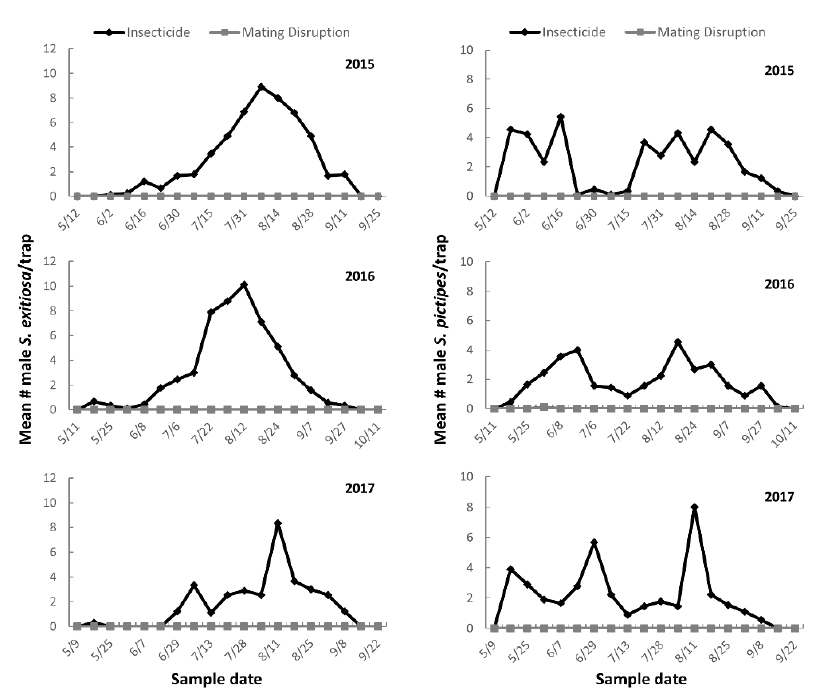
Figure 1. Mean number of male S. exitiosa and S. pictipes captured throughout the season in pheromone-baited traps in 2015–2017.